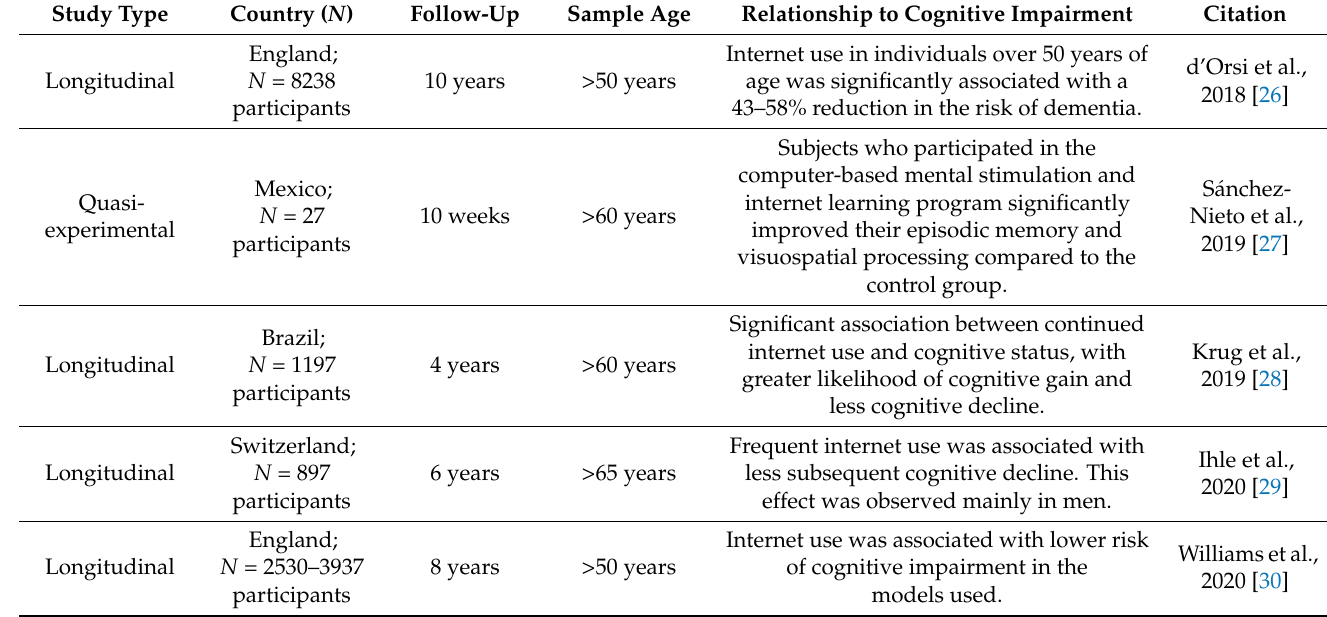
Table 2. Bibliographic citations related to internet and their relationship against